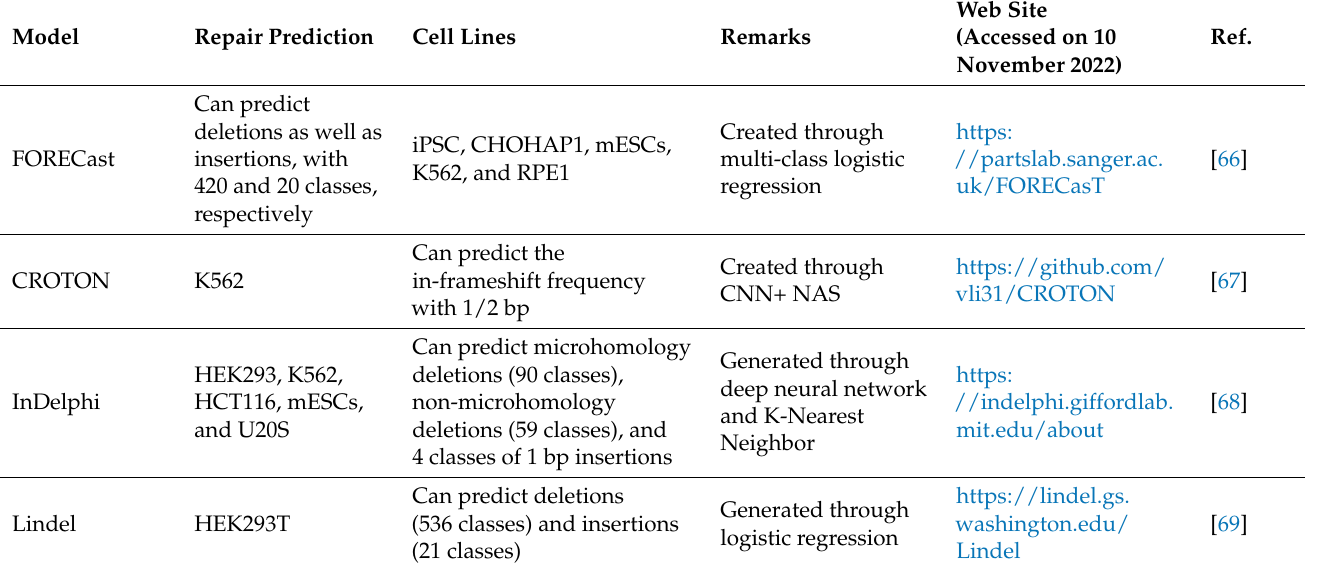
Table 3. Repair outcome prediction